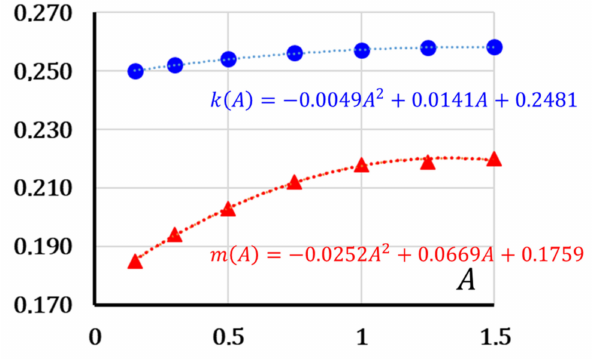
Figure 5. Evolution versus A of the exponent m ( A ) and coefficient k ( A ) of Equation (8). Values calculated by means of Equation (9) denoted as determined with the direct simulations represented in Figure 6 is acceptable, varying between − 6.6 and +6.9%, with an average value of +0.8%.